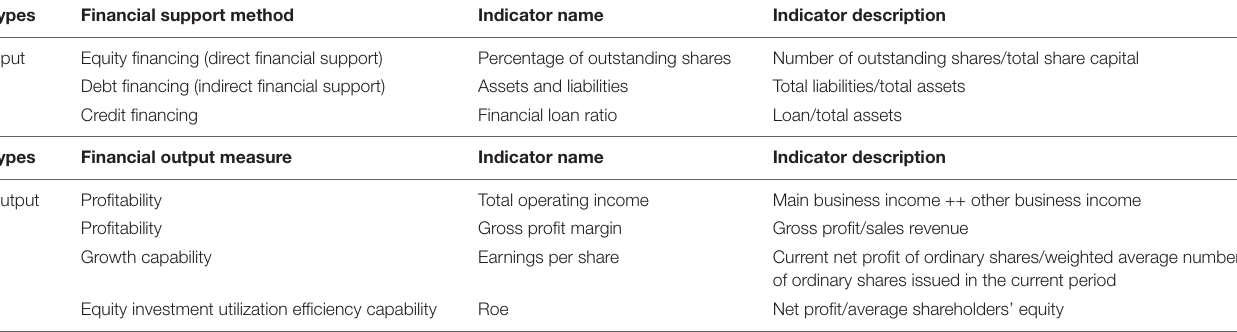
TABLE 1 | Measurement of high-quality input-output indicators of energy finance.